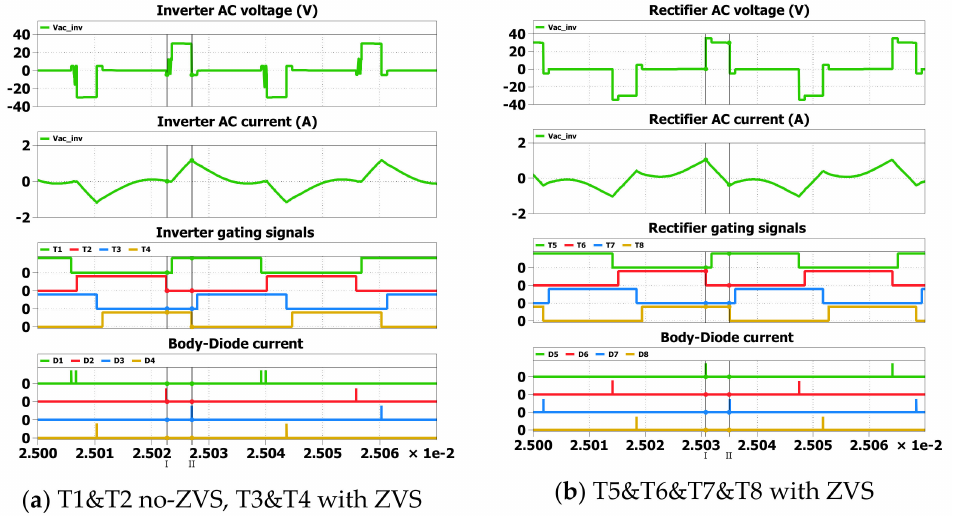
Figure 16. Inverter/rectifier voltage/current, MOSFET gating signals, diode currents PLECS circuit simulation results for Vo = 30 V, Io = 0.1 A (R dc = 300 Ω , emulate CV mode) with β p (deg) = 48.3 ◦ , β s (deg) = 46.2 ◦ , δ (deg) = 90 ◦